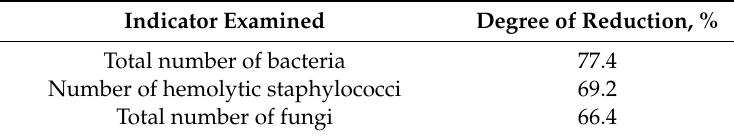
Table 1. Degree of reduction of bacterial